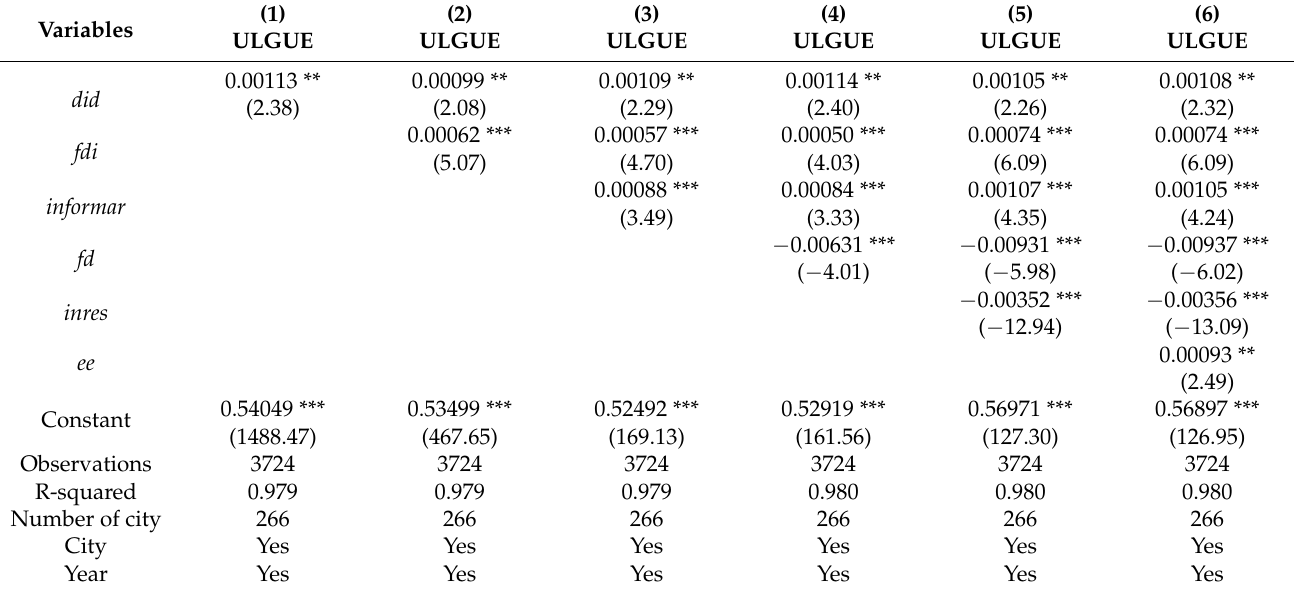
Table 4. Basic regression results.